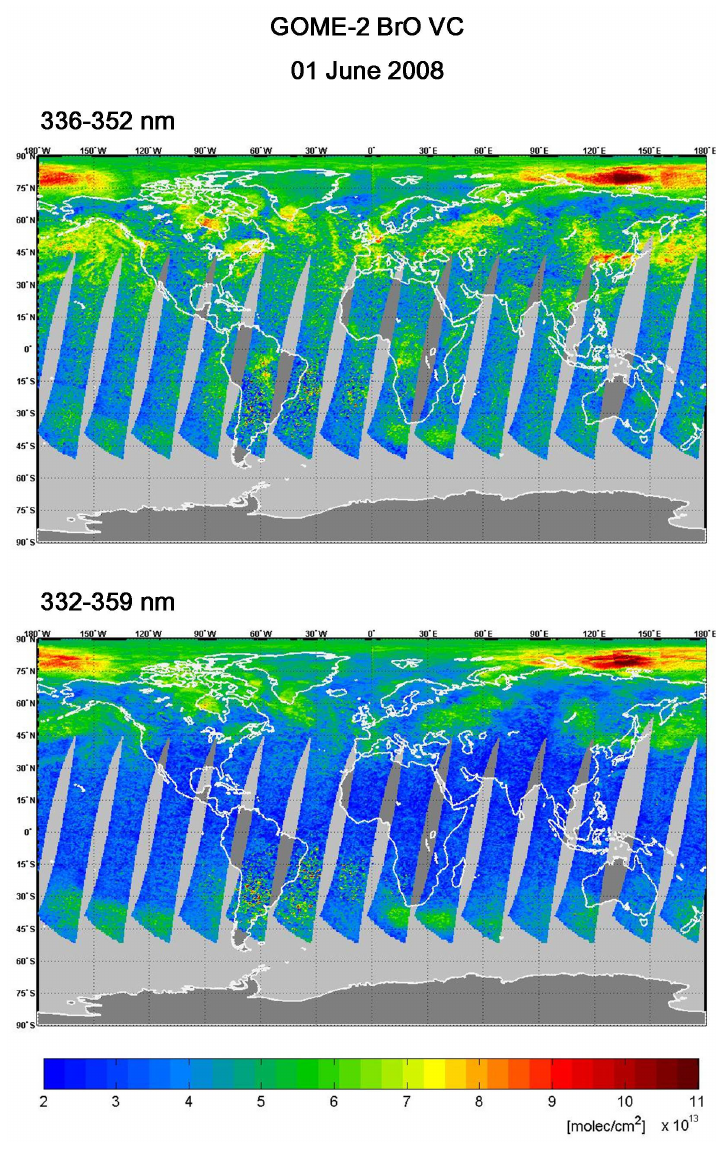
Fig. 1. Comparison of GOME-2 BrO vertical columns for 1 June 2008 using (upper map) the 336–352nm fitting window from Theys et al. (2009a) and (lower map) the 332–359nm interval introduced in this study. Simple geometrical air mass factors have been used to convert BrO slant columns into vertical columns. Note the reduced artefacts due to formaldehyde interference (e.g., in East China or Central Africa), the elimination of the viewing angle dependence and the reduced cloud-related